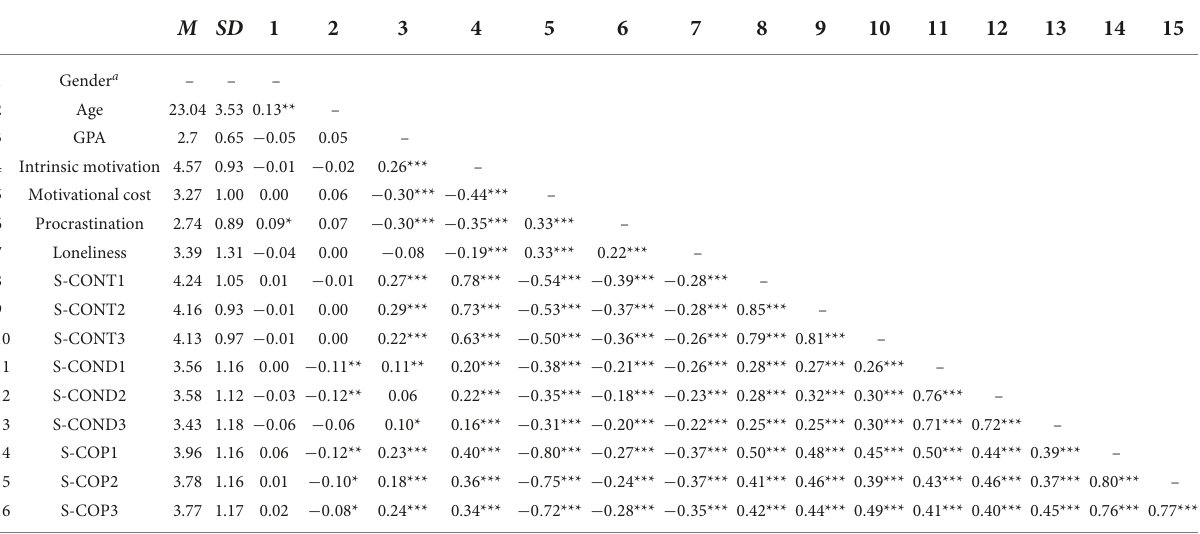
TABLE 5 Means, standard deviations, and correlations between sociodemographics, predictor variables and subdimensions of study satisfaction in study 2.